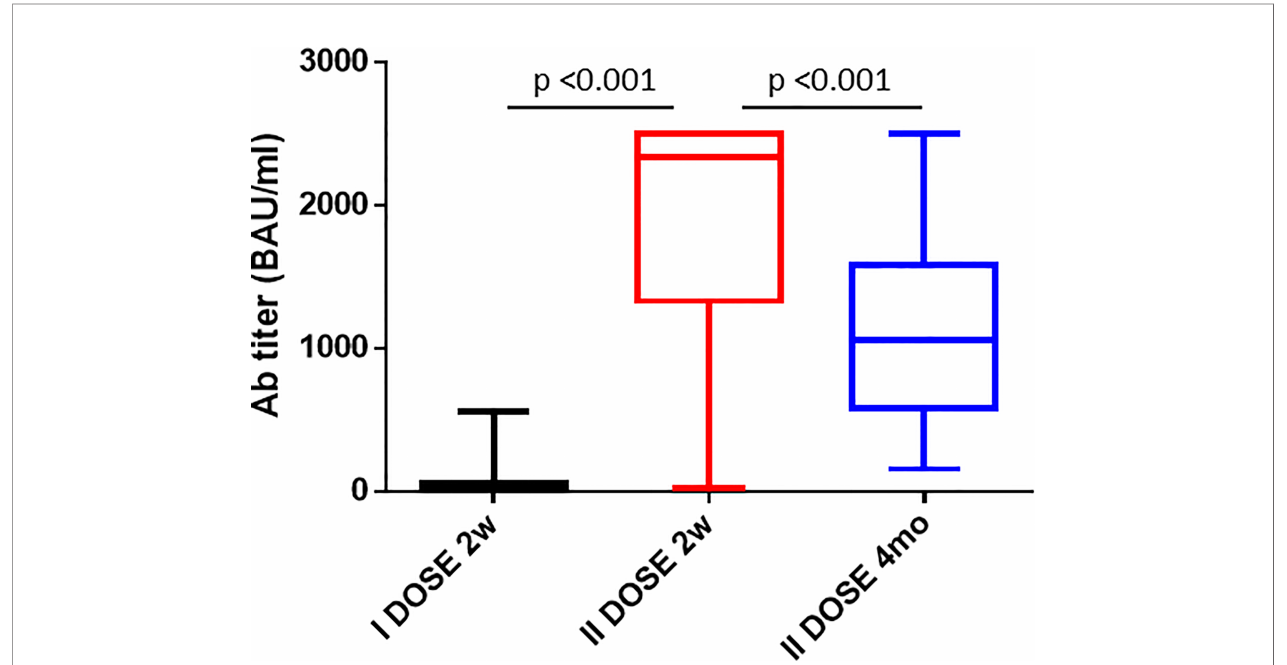
FIGURE 2 | Antibody titers after the 1 st and 2 nd dose of the P fi zer-BioNTech BNT162b2 vaccine. The cumulative Ab titers in the cohort of enrolled vaccinees is shown 2 weeks after the 1 st dose, 2 weeks and 4 months after the 2 nd